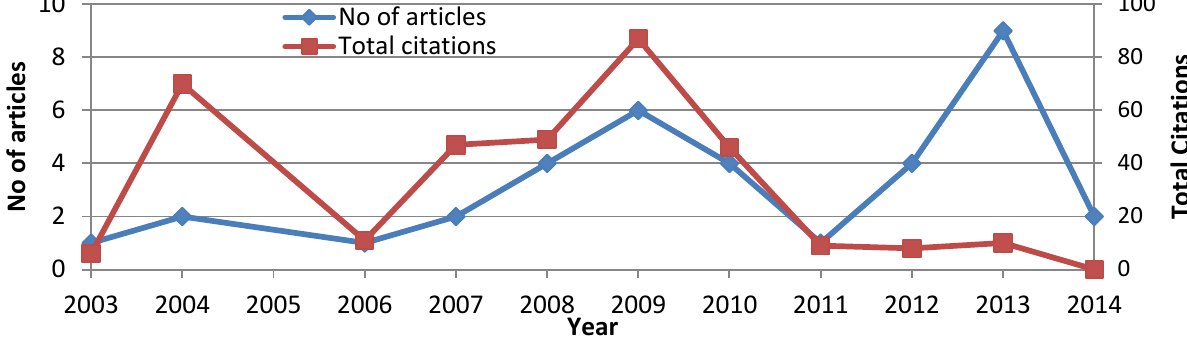
Figure 3. Number of institutions by countries.